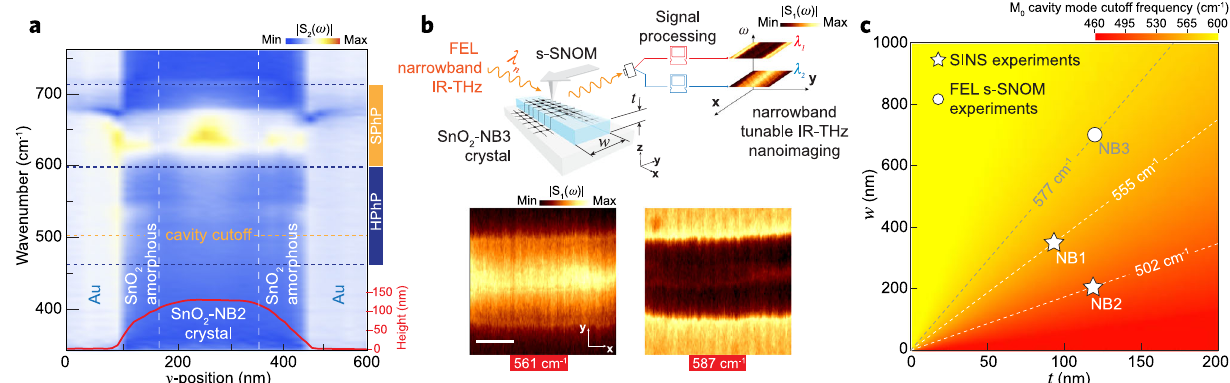
Fig. 4 SINS and FEL s-SNOM control measurements outside NBs cavity condition. a Experimental SINS amplitude S 2 ( ω ) spectral linescan across the SnO 2 -NB2 crystal ( t = 130 nm, w = 200 nm). Red line pro fi le at the bottom illustrates the AFM topography pro fi le of the NB. Vertical white-dashed lines delimit amorphous and crystalline SnO 2 phases. Horizontal blue dark-dashed lines denote the volume (HPhPs) and surface (SPhPs) phonon polaritons spectral ranges. The horizontal orange dashed line indicates the cutoff frequency for this NB. b (top) Tunable THz-IR ( λ n ) s-SNOM nano-imaging experimental scheme and FEL s-SNOM narrowband maps (bottom) of the SnO 2 -NB3 ( t = 117 nm, w = 700 nm) for the frequencies 561 and 587 cm − 1 . Scale bar represents 300 nm. c Cavity cutoff frequency map for M 0 modes as a function NBs thickness ( t ) and width ( w ). Isofrequency diagonal-dashed lines denote M 0 mode cavity cutoff for the SnO 2 -NB1, -NB2, and -NB3, analyzed by SINS and FEL s-SNOM in this